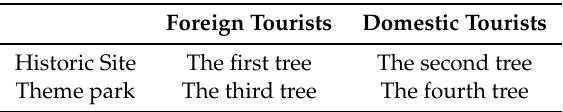
Table 2. The four decision trees to be analyzed.